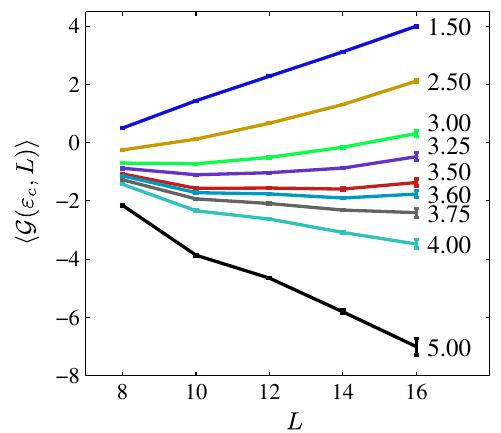
; L Þ in the middle of the band with the FIG. 3. Scaling of G ð ε c system size for different disorders W ¼ 1 . 5 ; … ; 5 . The value of disorder is shown on the right of each curve. From here, the 3 . 6 (cid:2) 0 . 15 critical disorder strength is determined as W c ¼